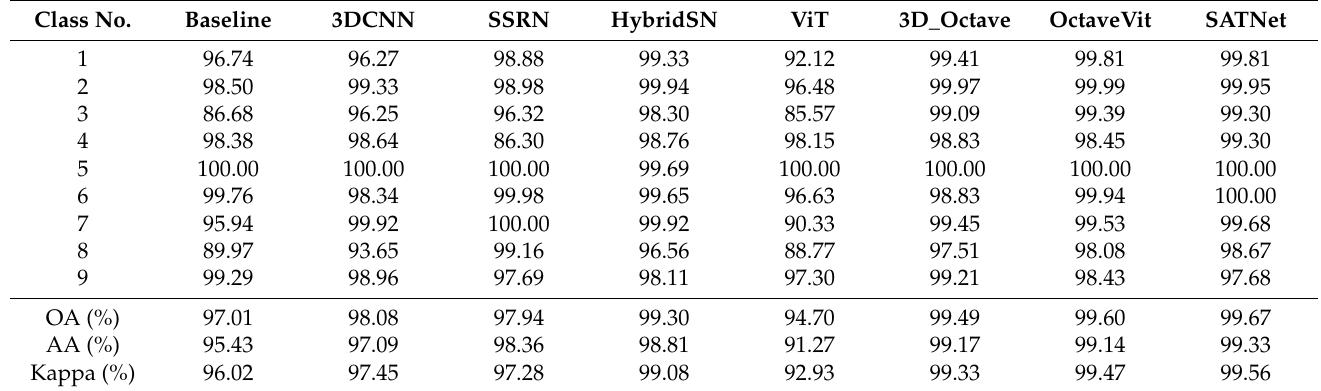
Table 7. Test accuracy with different preprocessing methods on the UP dataset.